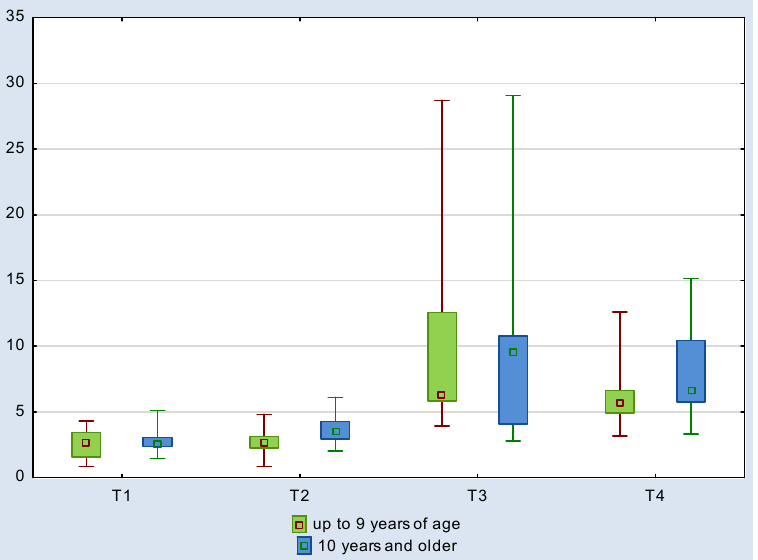
Figure 2. Cortisol level in mare saliva taking into account age, median, percentiles and Kruskal–Wallis test ( ≤ 9 years of age—KW-H(3.36) = 22.083; p = 0.0001; ≥ 10 years of age: KW-H(3.36) = 16.1772; p = 0.0010). The variables after the endurance–condition test are characterized by right-handed asymmetry. In contrast, half of the most typical data (box) are characterized by high similarity. Explanations as in Table 1.